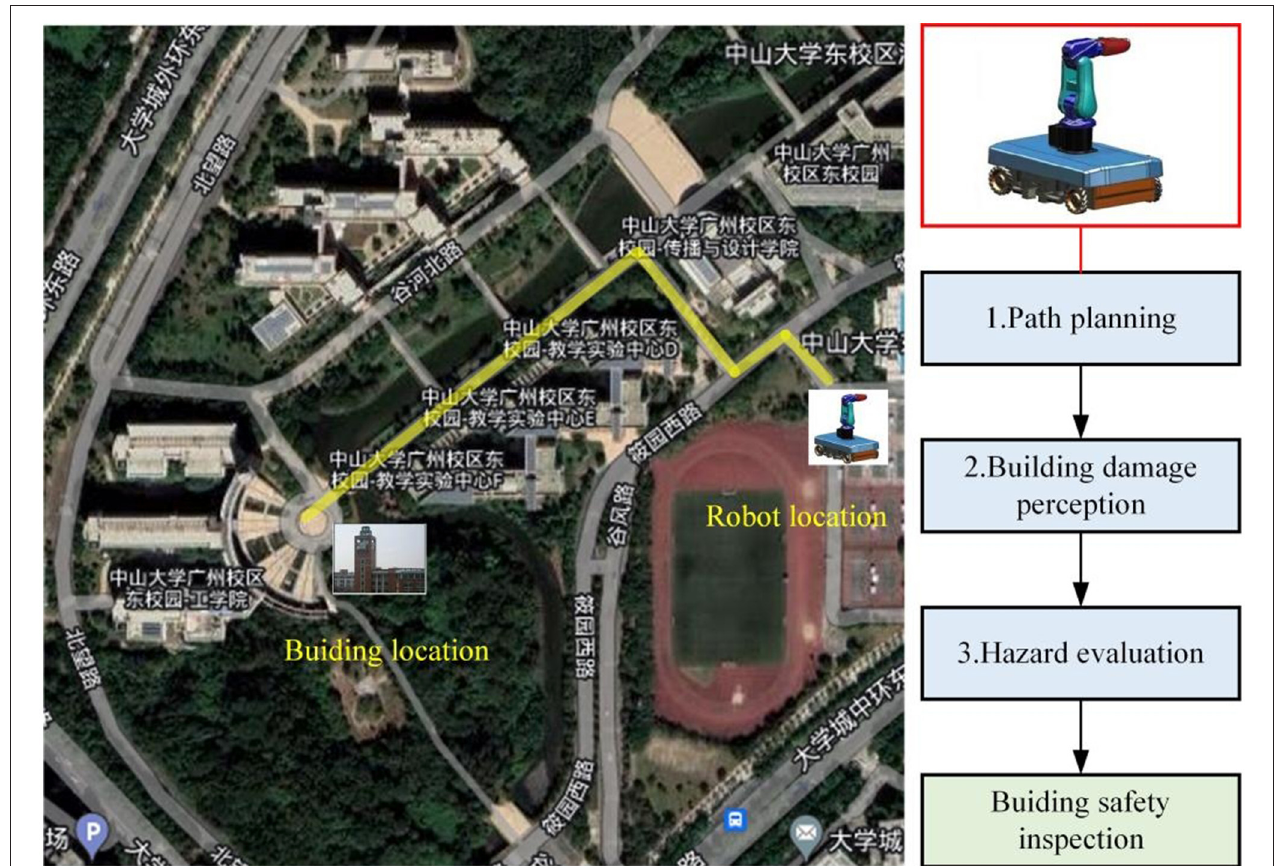
FIGURE 1 | Robot designed for the post-earthquake inspection and